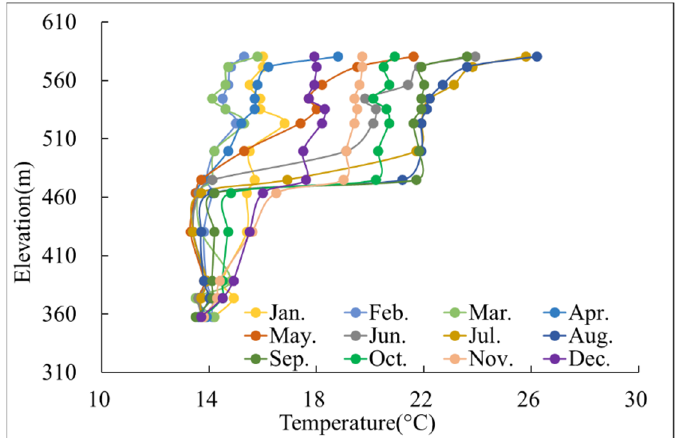
Figure 8. Measured reservoir water temperature.